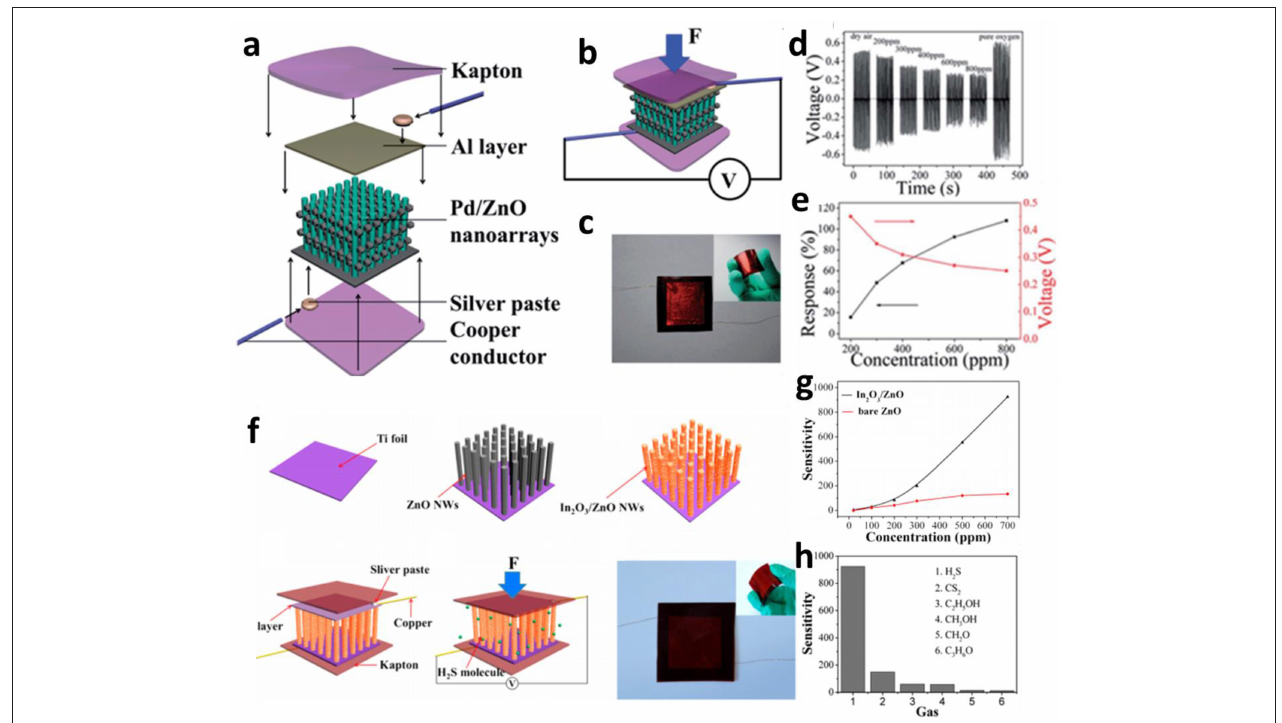
FIGURE 8 | (a) Fabrication schematic of the self-powered active ethanol sensor based on Pd/ZnO nanoarray. (b) Electrical configuration and device structure of Pd/ZnO nanoarray. (c) The image displaying the flexibility of sensor device. (d) The dynamic piezoelectric response toward ethanol at room temperature. (e) The dependence of the sensitivity on the concentration of target analyte ethanol. Reprinted with permission from Lin et al. (2014), copyright the Royal Society of Chemistry 2013. (f) Fabrication protocol of the self-powered active gas sensor based on In 2 O 3 /ZnO nanowire arrays. (g) Comparison of sensing performance of In 2 O 3 /ZnO and pristine ZnO NW arrays upon exposure to H 2 S. (h) Selectivity histogram of the sensor upon exposure to 700 ppm of H 2 S and other interfering gaseous analytes at room temperature. Reprinted with permission from Zang et al. (2014), copyright 2014 American Chemical